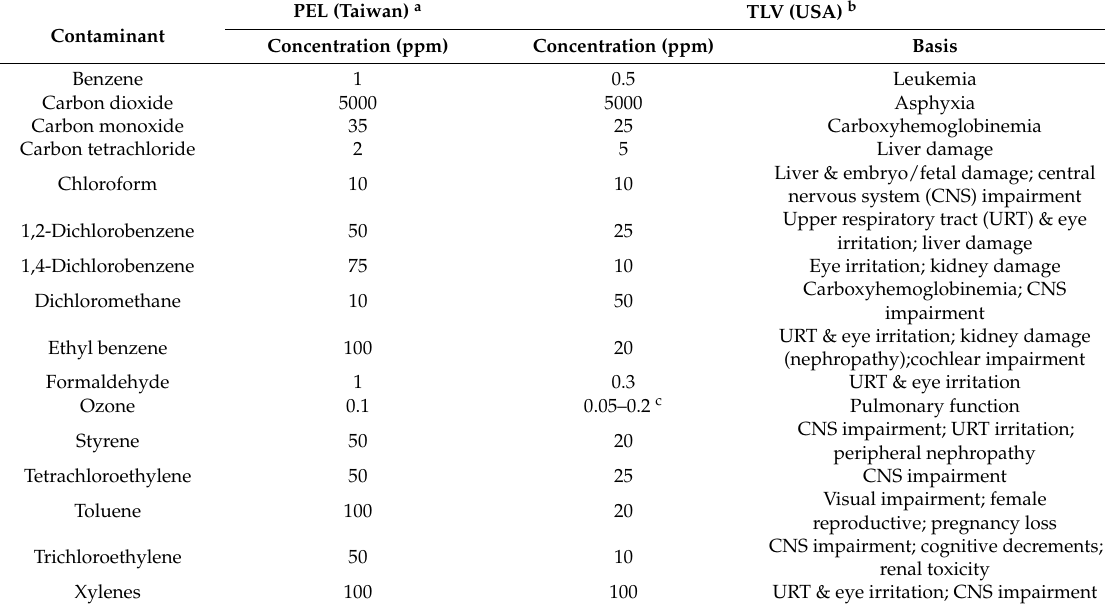
Table 2. Occupational exposure limits for designated air pollutants in indoor